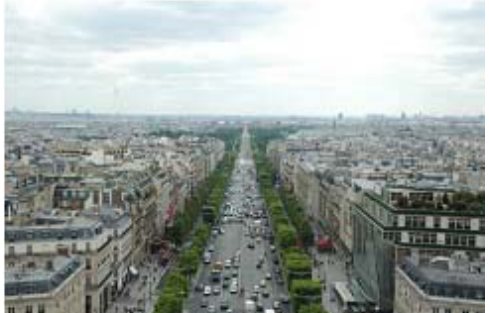
Fig. 6. View from Arc de Triomphe, Paris (France).